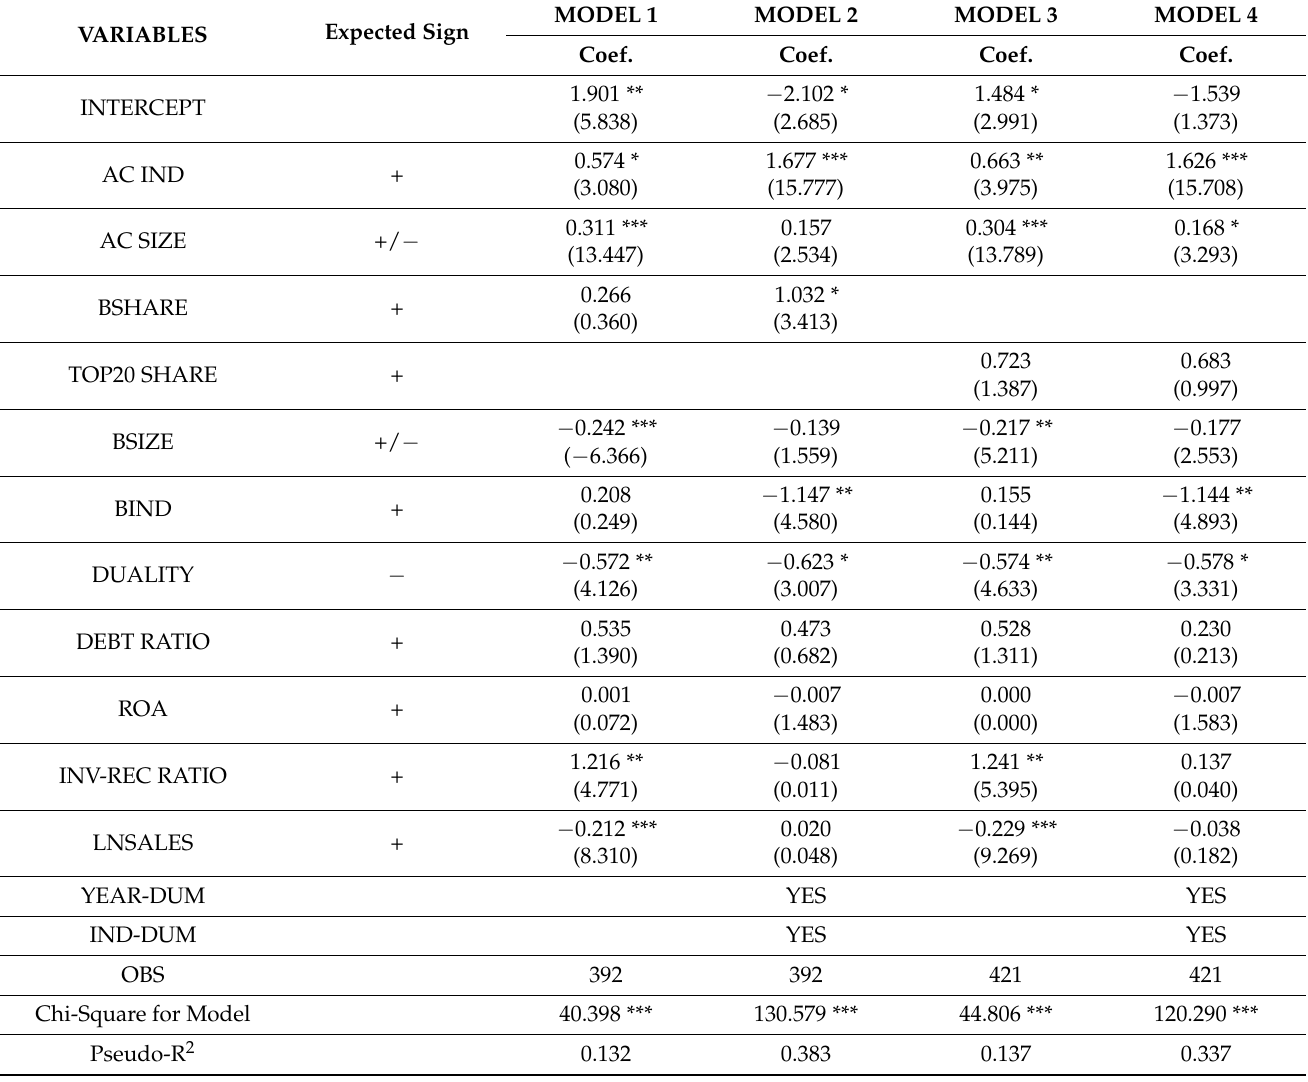
Table 5. Logistic regression results (agency costs: TOBIN’S Q